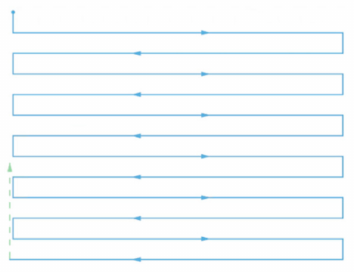
Figure 1. An instance of a Boustrophedon